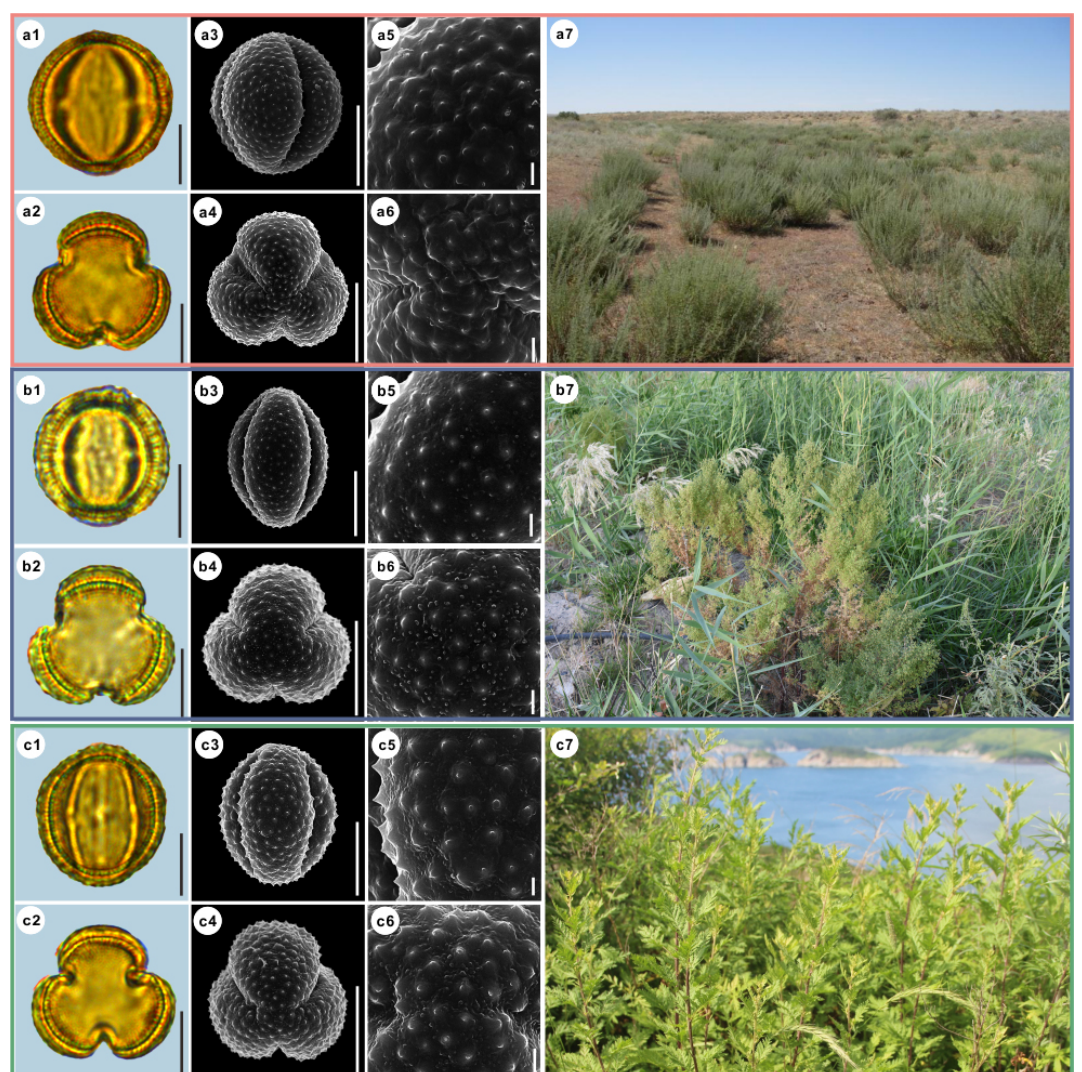
Figure 8. Pollen grains and the habitats of their source plants. (a) Artemisia aralensis ; (b) Artemisia annua ; and (c) Artemisia freyniana . Pollen grains in equatorial view under LM (a1, b1, c1) and SEM (a3, a5, b3, b5, c3, c5) , in polar view under LM (a2, b2, c2) and SEM (a4, a6, b4, b6, c4, c6) , along with the habitats of their source plants (a7 cited from https://www.plantarium.ru/lang/en/page/image/id/73063.html, last access: 19 August 2022, by © , b7 provided by © Chen Chen, c7 cited from https://www.inaturalist.org/photos/ 154390279, last access: 19 August 2022, by © ) . Scale bar in LM and SEM overview 10µm, and in SEM close-up